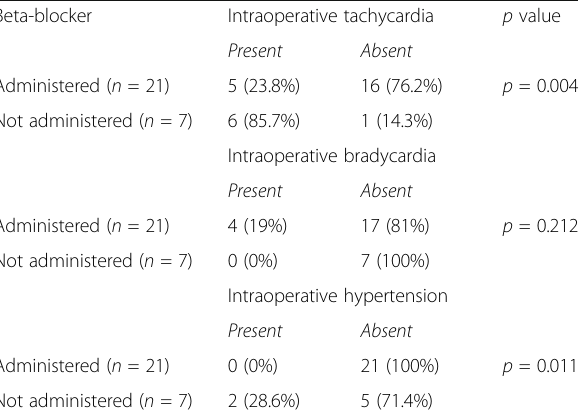
Table 4 Relation of use of beta-blocker with postoperative tachycardia, bradycardia, and hypertension in GPU